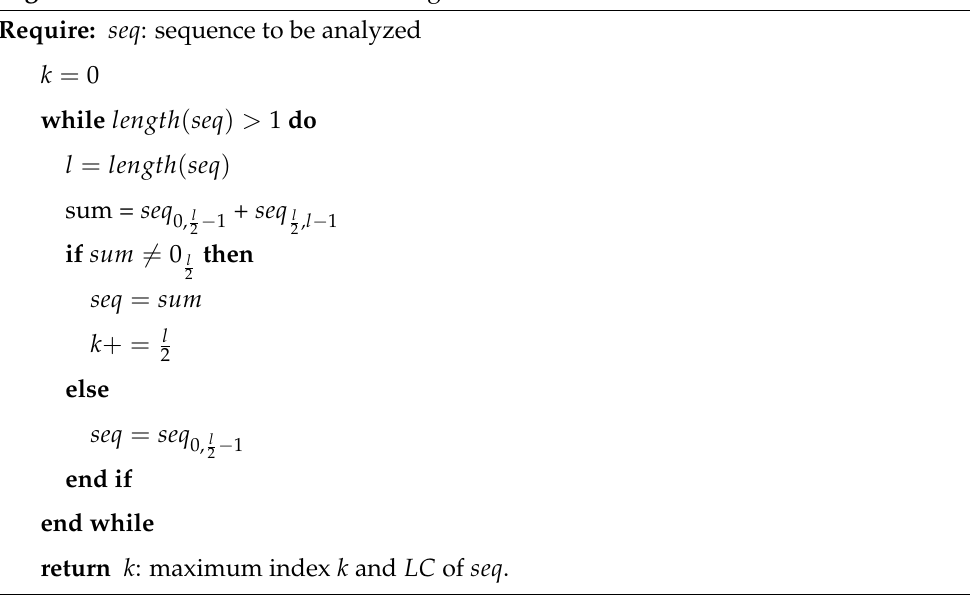
Algorithm 3 The half-interval search